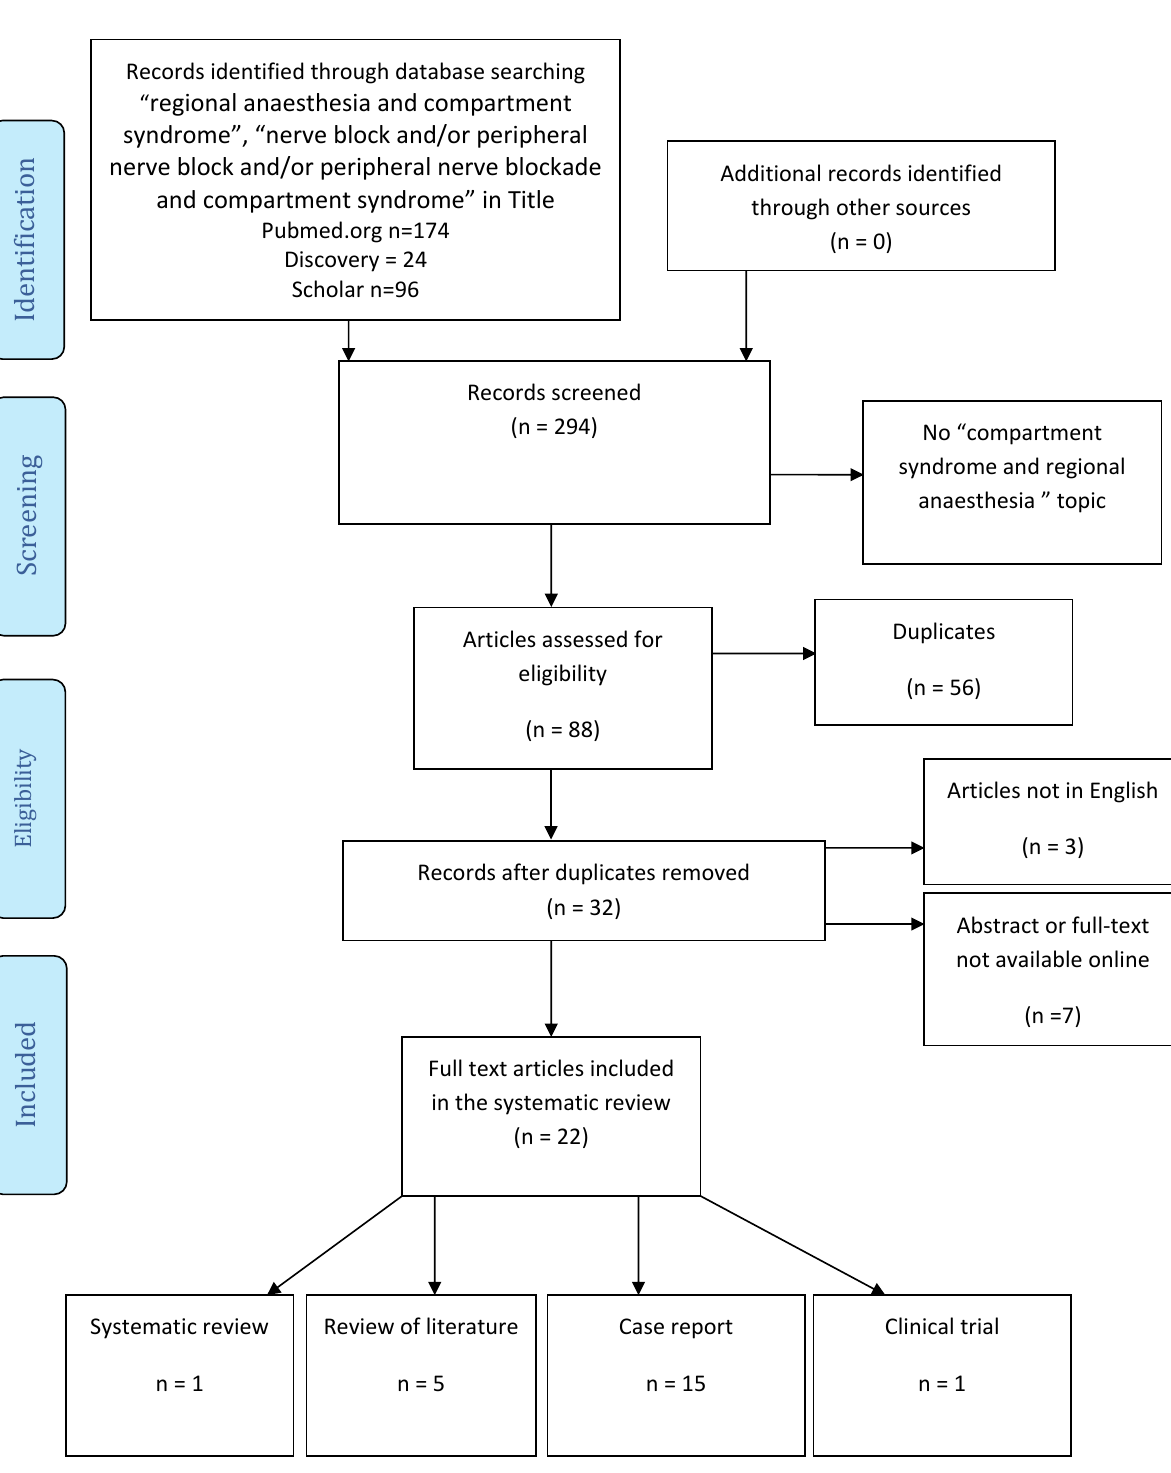
Fig. 1. Data search diagram.